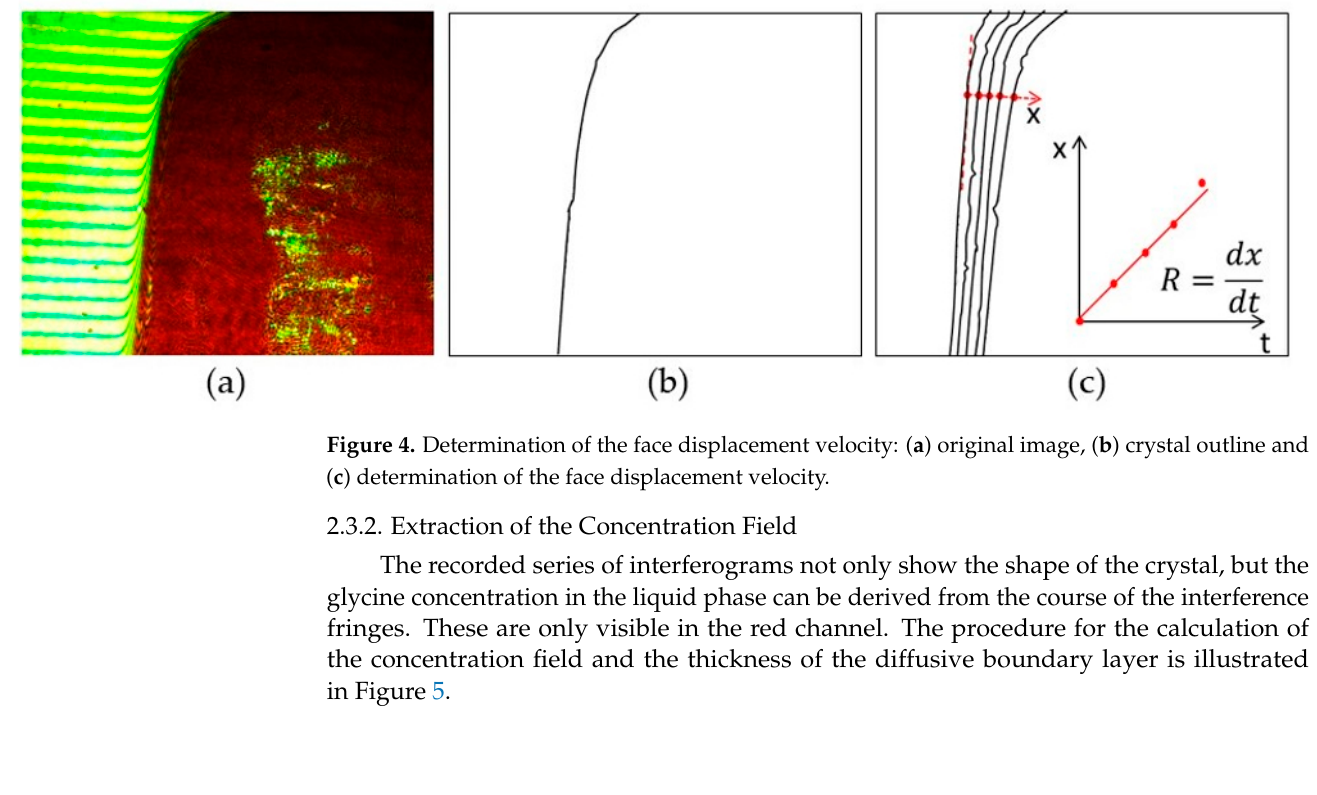
Figure 3. Typical α -glycine crystal: ( a ) photography, ( b ) µ-CT image with indexed crystal facets.